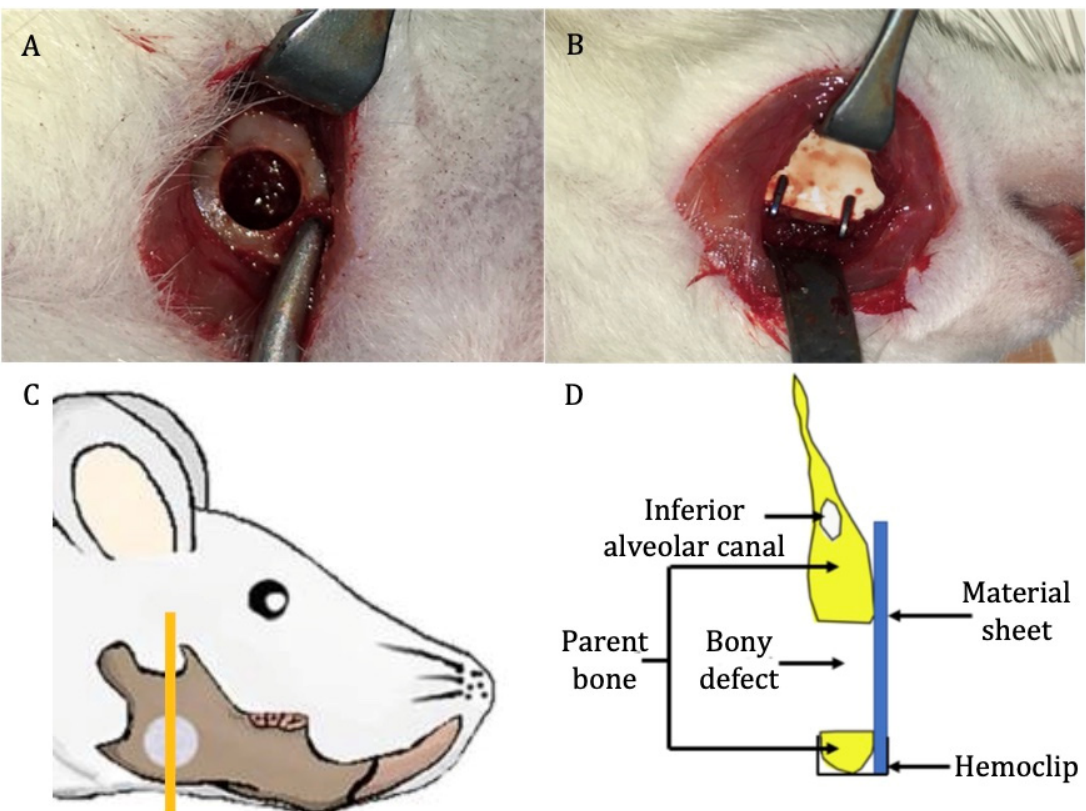
Figure 2. Surgical procedure. ( A ) Critical-size defect created at the mandibular angle on the right side. ( B ) Placement of reconstructive material. ( C ) Site of sample taken for analysis (the orange vertical line) (image modified from Sha et al. [18]). ( D ) Schematic coronal view of the specimen.